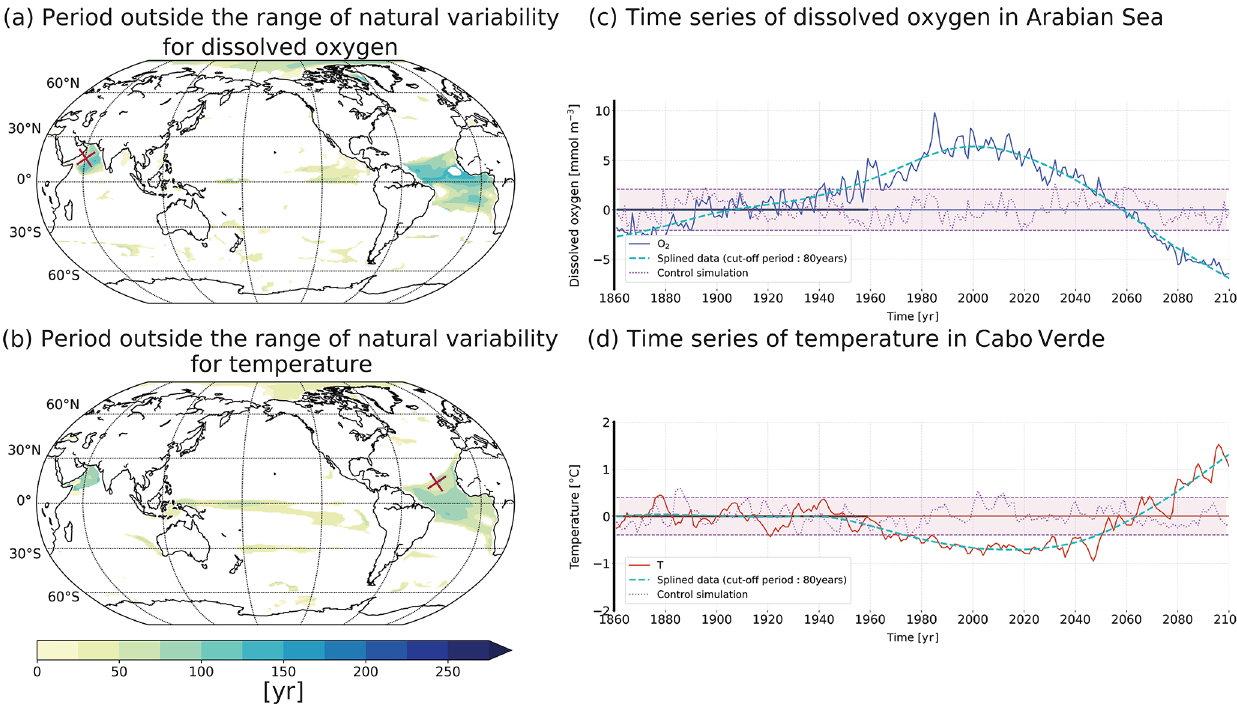
Figure A2. Period outside the range of natural variability for (a) oxygen concentration and (b) temperature in the thermocline for the model HadGEM2. The time series show two examples of the temporal evolution of the oxygen concentration (c) and temperature (d) for a single grid point: red crosses in panels (a, b) : Arabian Sea (c) and equatorial Atlantic (d)